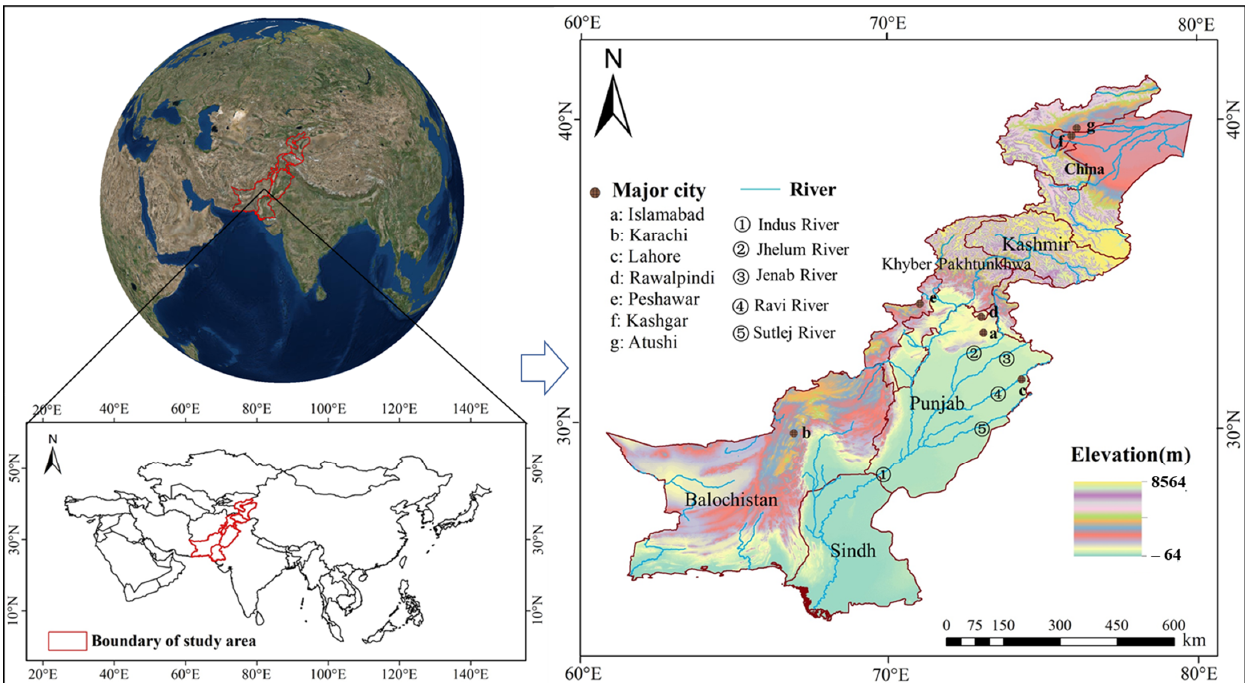
Figure 1. Location of the CPEC, IRB, TRB, and river systems (Drawing approval number: GS (2019)1822).